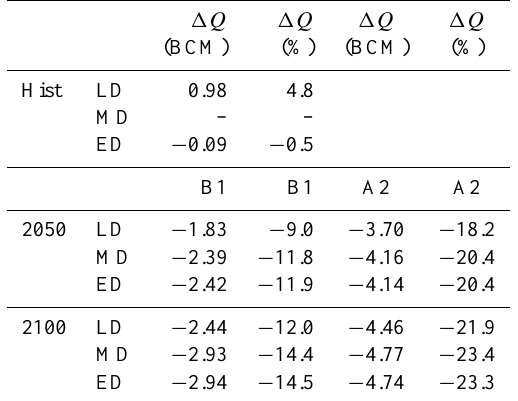
Table 5. Change in runoff ( Q ) at Lees Ferry relative to historic cli- mate with moderate dust loading (MD historic).